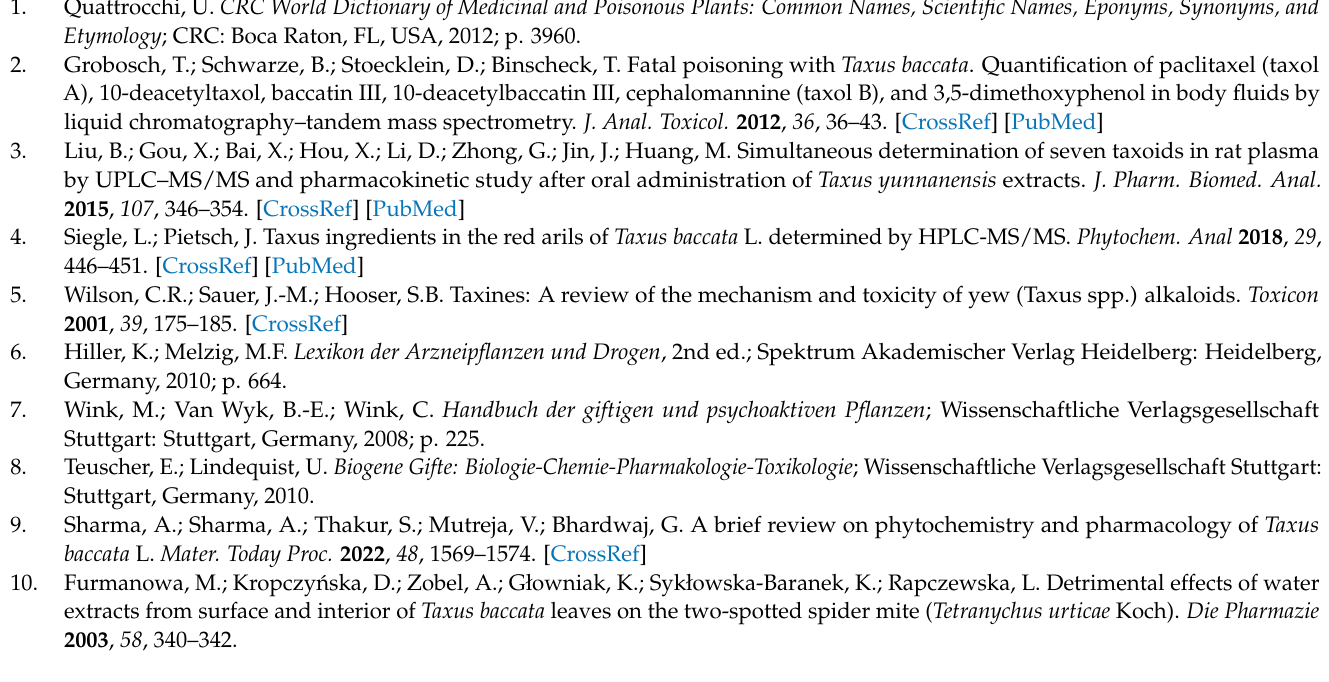
extract; Figure S4: Examples of determination of minimum inhibitory concentrations of conventional antibiotics (for clinical use) against P. carotovorum subsp. carotovorum ; P. atrosepticum ; P. parmen- tieri ; and D. chrysanthemi using ETEST ® gradient MIC strips; Table S1. Phytochemicals identified by GC–MS in T. baccata leaf aqueous ammonia extract; Table S2. Main phytochemicals